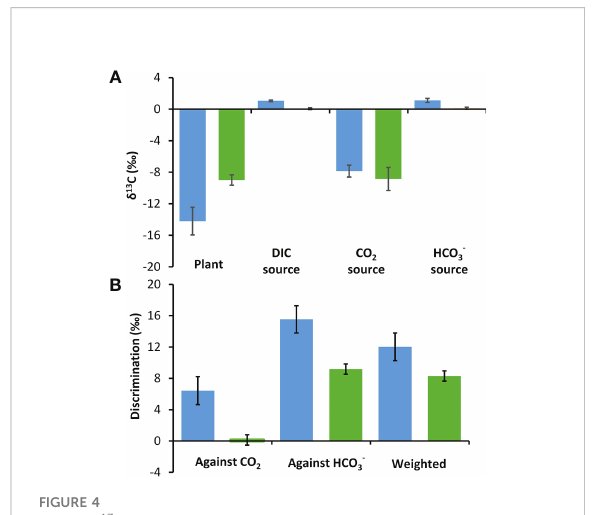
FIGURE 4 Stable d 13 C in P. oceanica (blue) and Z. marina (green) and their potential inorganic carbon sources. (A) Measured d 13 C organic carbon values of the seagrasses and of DIC and calculated CO 2 and HCO − 3 d 13 C sources at their collection site. (B) Discrimination against CO 2 , HCO − 3 and the overall discrimination weighted according to estimated proportional use of these two sources of inorganic carbon (Figure 3C). Error bars show one standard deviation for fi ve